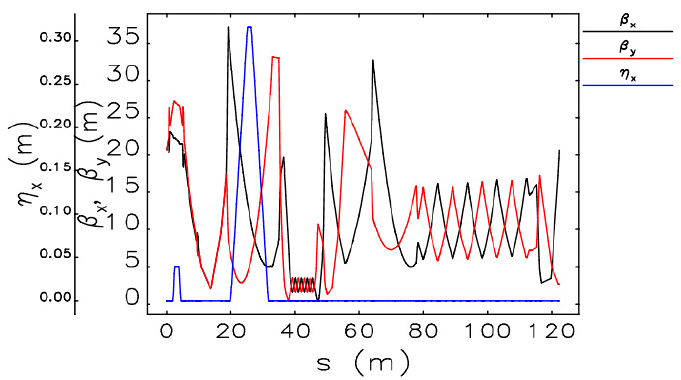
Figure 4. Twiss functions along the main linac.